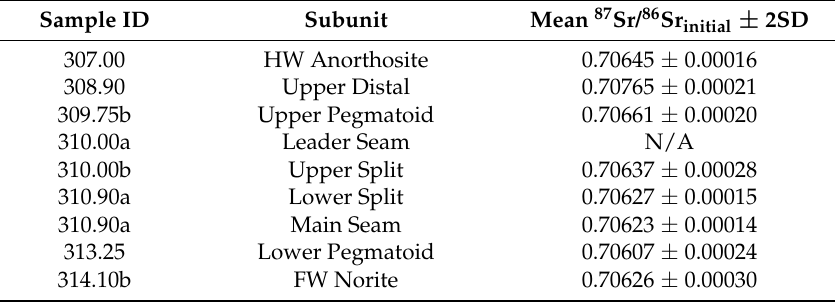
Table 2. Mean 87 Sr/ 86 Sr initial ratios of